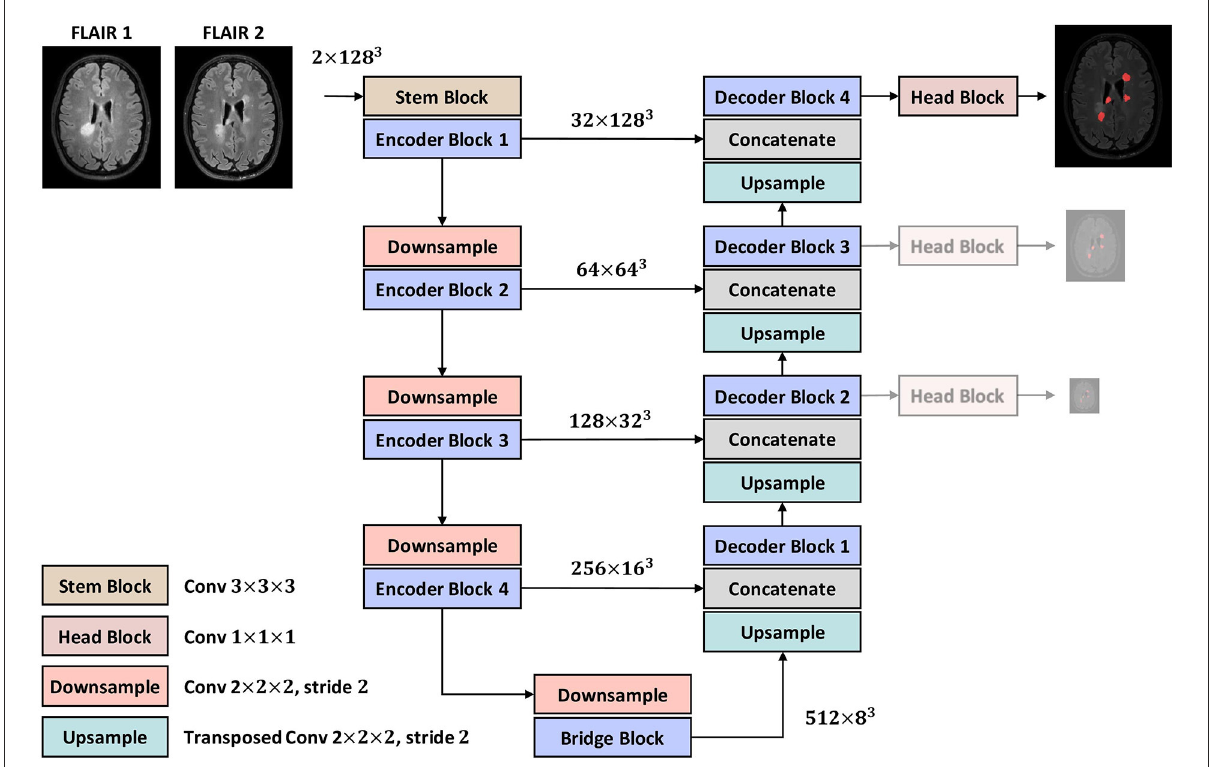
FIGURE2 The proposed encoder-decoder architecture. The two lower-resolution auxiliary maps are only used in the training phase as deep